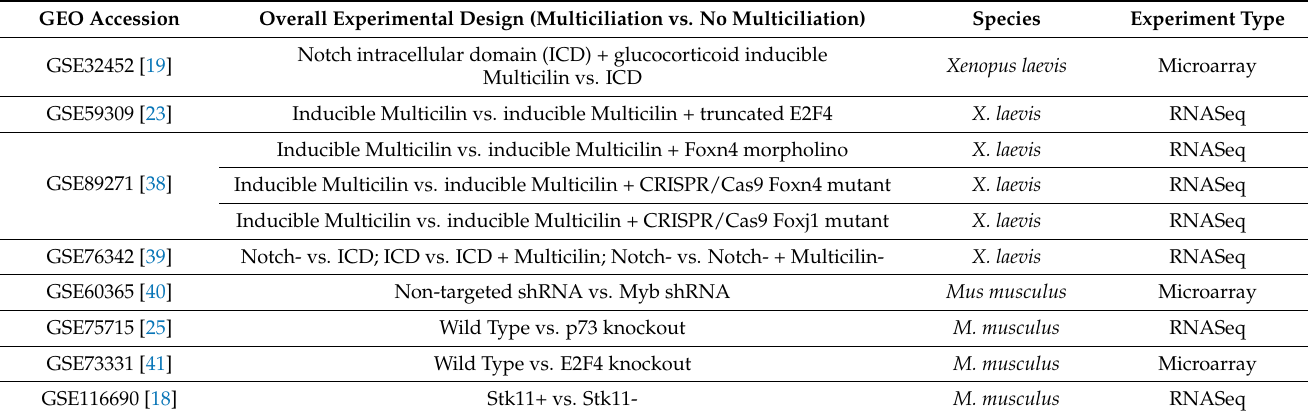
Table 1. Overview of the different datasets and experiments used for the functional analysis. GEO Accession Overall Experimental Design (Multiciliation vs. No Multiciliation) Species Experiment Type Notch intracellular domain (ICD) + glucocorticoid inducible Xenopus laevis Microarray GSE32452 [19] Multicilin vs. ICD GSE59309 [23] Inducible Multicilin vs. inducible Multicilin + truncated E2F4 X. laevis RNASeq X. laevis GSE89271 [38]